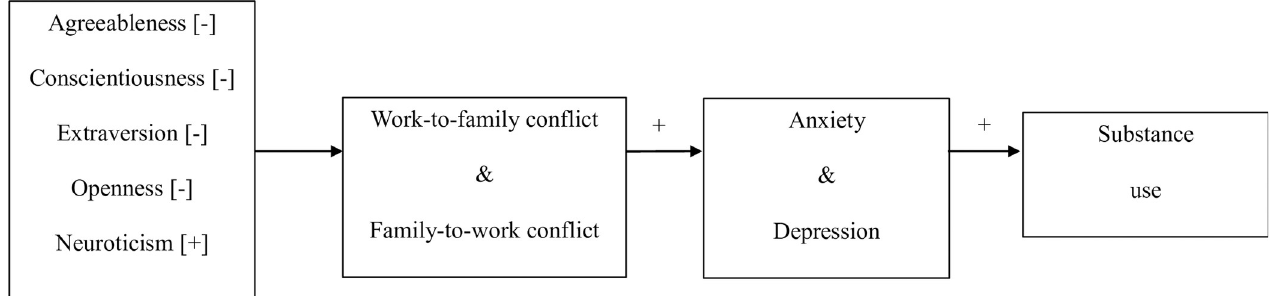
Fig 2. Hypothesized model. The model of some antecedents and outcomes of work-family and family-work conflict.